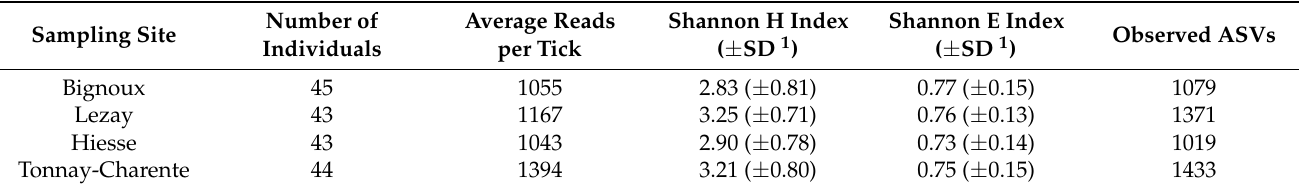
Table 1. Diversity index calculated for each sampling site. Calculations were carried out after probable contaminant reads removal. An uneven number of individuals is due to samples exclusion based on the Bray-Curtis dissimilarity index cal- culation.